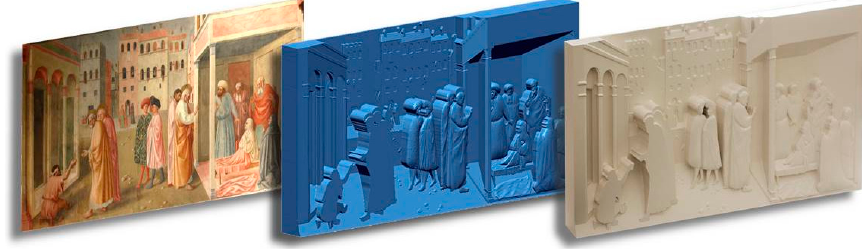
Figure 2. “Guarigione dello storpio e resurrezione di Tabita” by Masolino da Panicale: original artwork, digital 3D model and 3D-printed bas-relief.